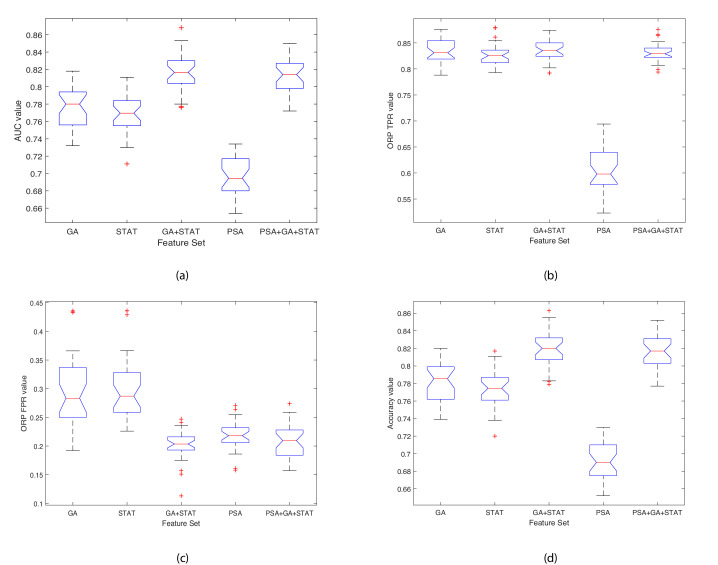
Boxplots illustrating the performance of the proposed model using various feature sets.(a) Average AUC values, (b) Average Optimal ROC points (TPRs), (c) Average Optimal ROC points (FPRs), (d) Average Accuracy values. Each box plot contains 30 points, where each point is the average performance evaluation value (i.e. AUC, ORP TPR, ORP FPR, Accuracy) from one 10-fold run using the various feature sets.